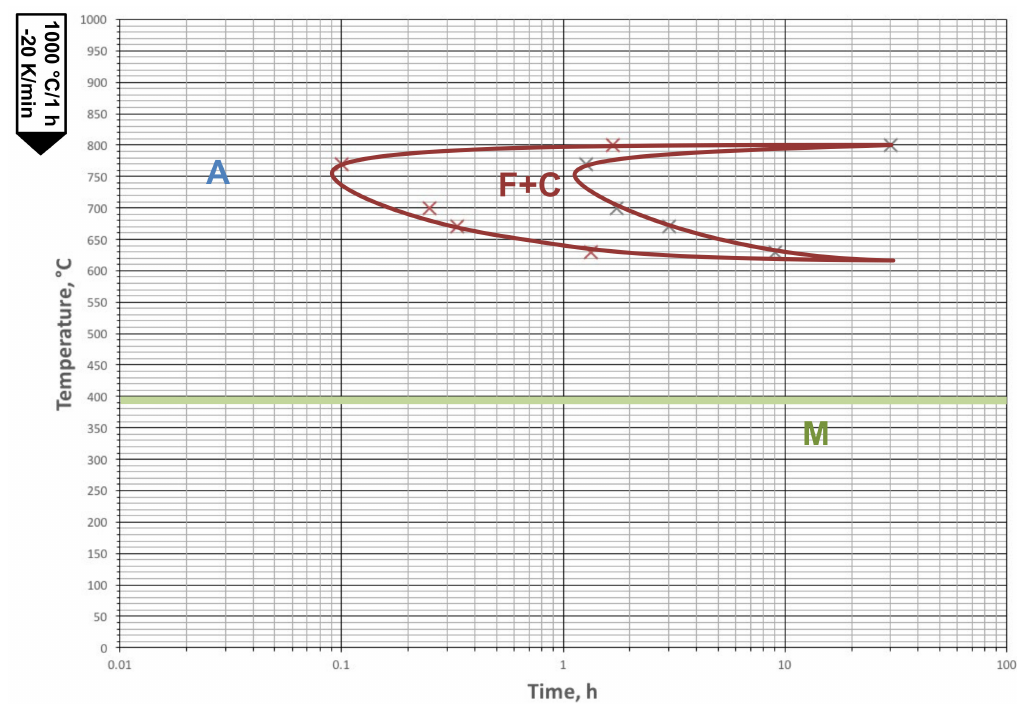
Figure 2. Time Temperature Transition (TTT) diagram for the experimental heat J361 (it is similar to EUROFER97/2 but without Mn) starting with austenitization for 60 min at 1000 ◦ C, followed by isothermal tempering (i.e., at constant temperature). This diagram corresponds to placing a piece material from one furnace at austenitization temperature to another furnace with a temperature given in this diagram. While changing the furnaces, the temperature drops with a rate of 20 K/minute. The corresponding horizontal line at this temperature indicates the start and end of a phase transition whenever the line enters or leaves a phase field boundary. The phases are denoted: austenite A, martensite M, ferrite F, carbide C. The crosses symbolize data that were determined by dilatometry. Note: For EUROFER97 steels the F + C phase field is slightly shifted towards longer durations and the martensitic phase starts at about 360 ◦ C.